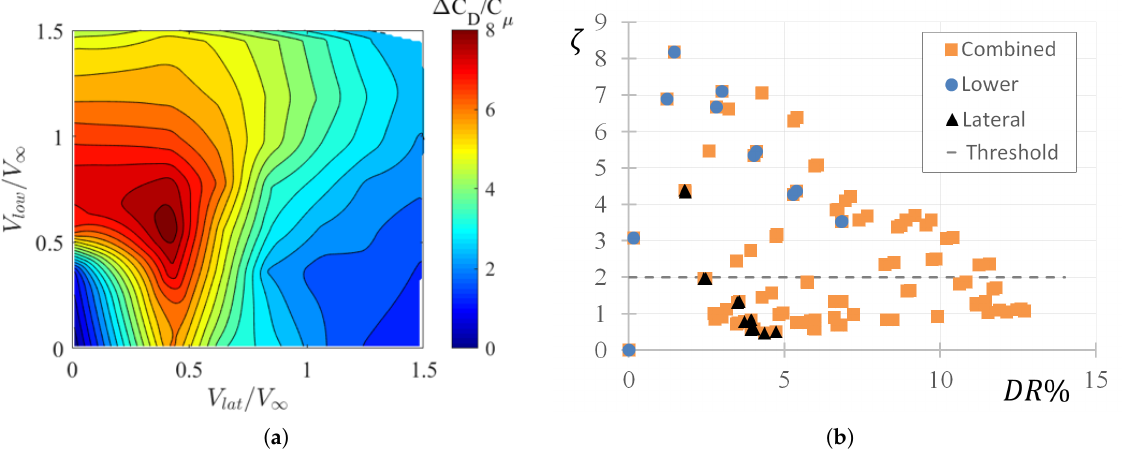
Figure 12. Wake receptivity using asymmetrical forcing: ( a ) lower and lateral jets; and ( b ) efficiency vs. DR % for standalone and combined jets